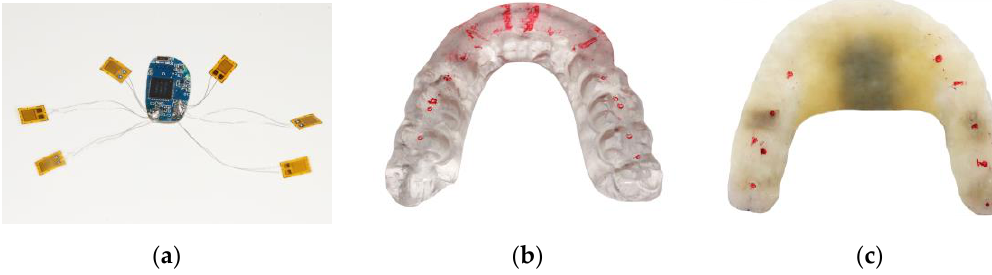
Figure 6. ( a ) Stress-sensitive chips and control chips; ( b ) occlusal contacts of an occlusal stabilization splint (OSS); ( c ) sensors packaged in the OSS.